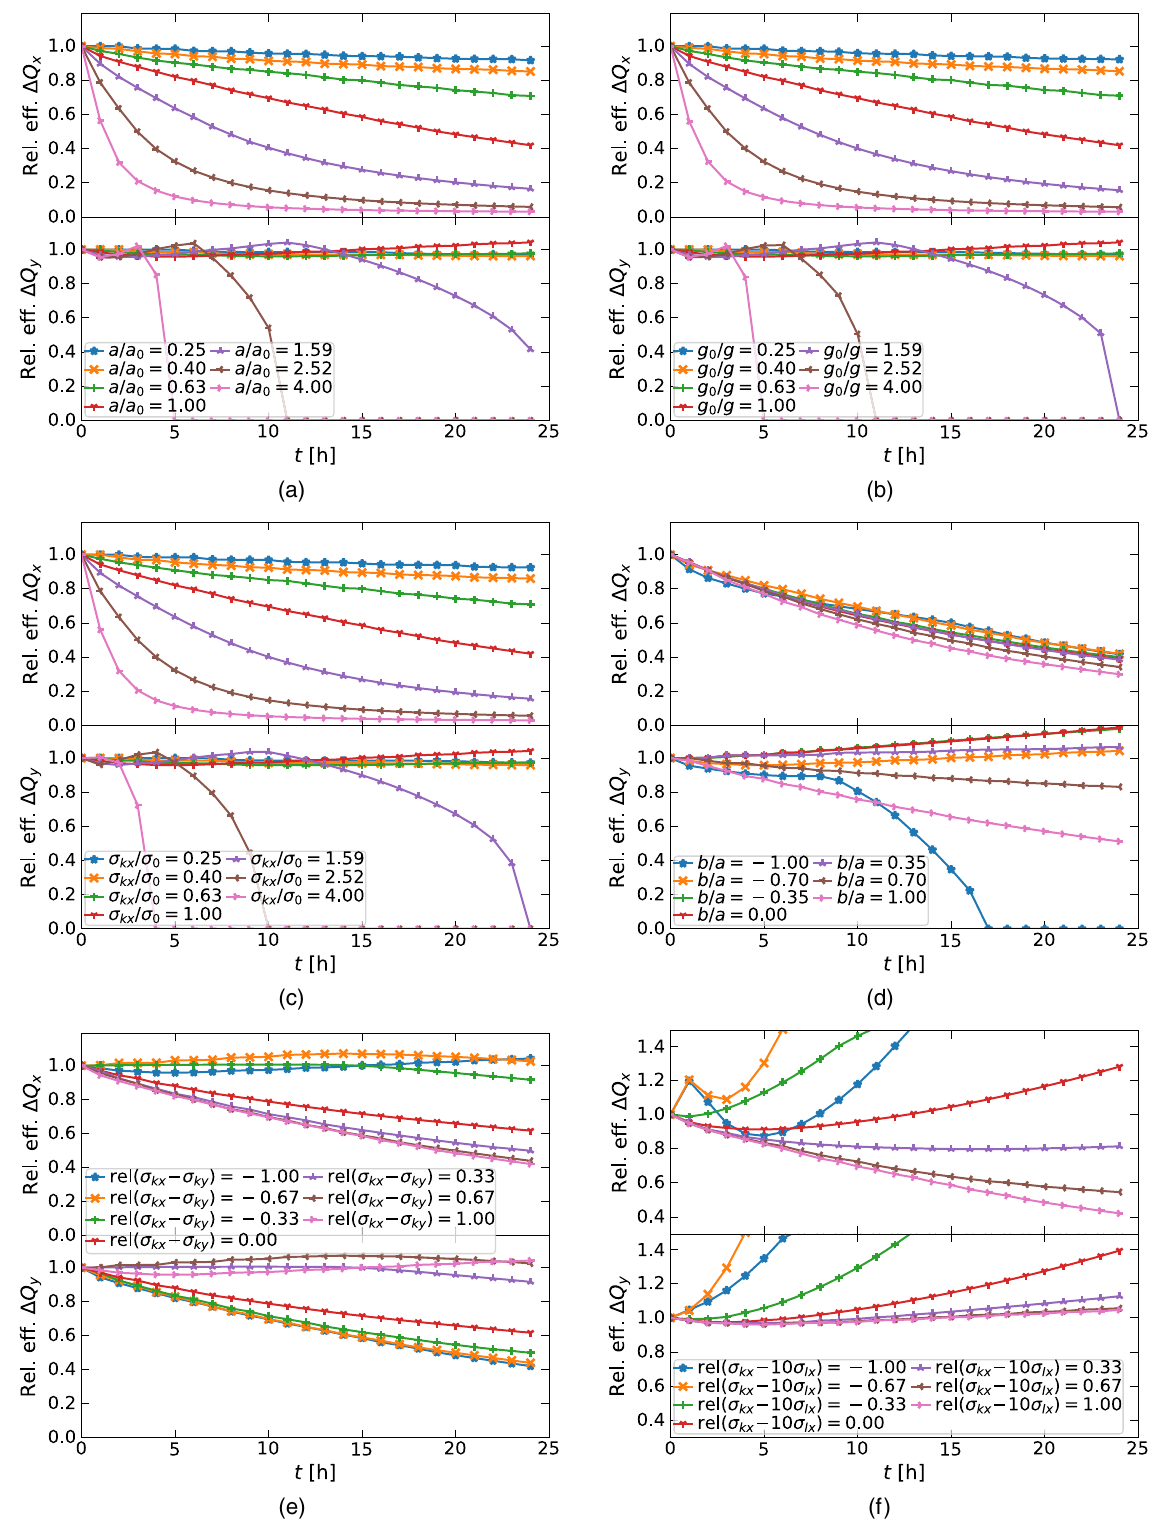
FIG. 8. Scan of a , g , σ , σ , σ , and b=a , given by the legends. The relative effective detuning strength is explained in Sec. IV B. The kx ky Ix relative difference in (e) and (f) is given by Eq. (27). The configuration in Fig. 5 is the same as a=a 0 ¼ 1 , g 0 =g ¼ 1 , σ − σ 1 , and rel ð σ − 10 σ 1 , respectively in order from (a) to b=a ¼ − 0 . 7 , rel ð σ kx ky Þ ¼ kx Ix Þ ¼